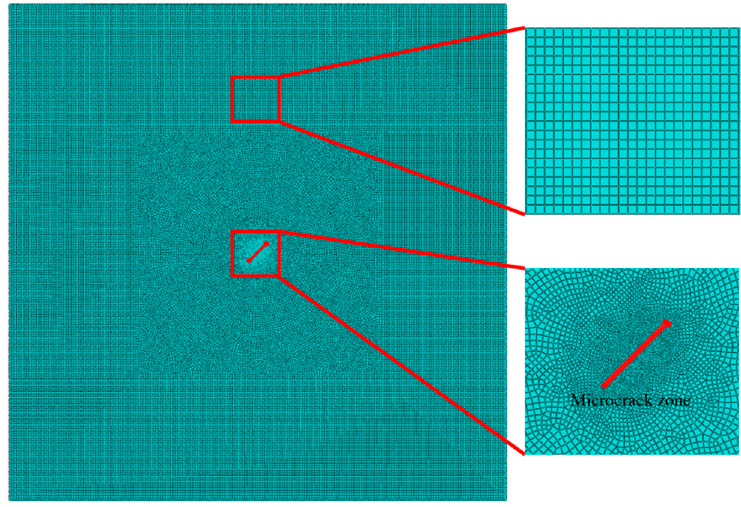
Figure 3. The meshes of local enlargement of the microcrack zone and the remaining region of the model.